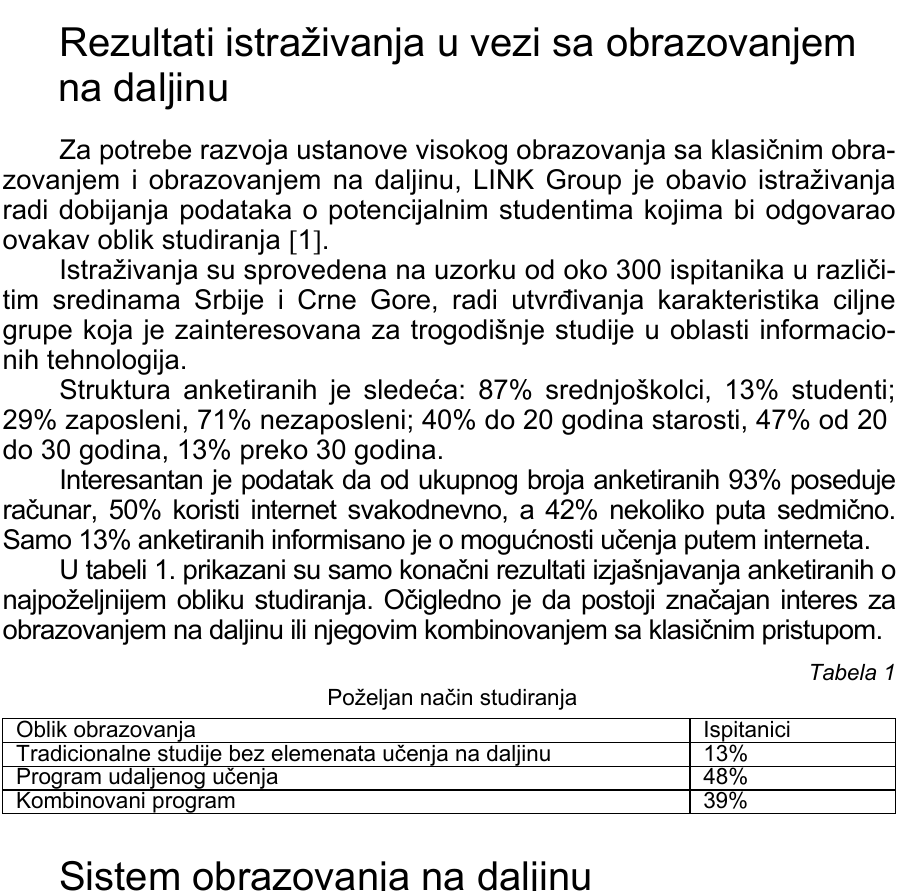
U Beogradskoj akademiji ra č unarskih nauka (BARN) uspostavljen je